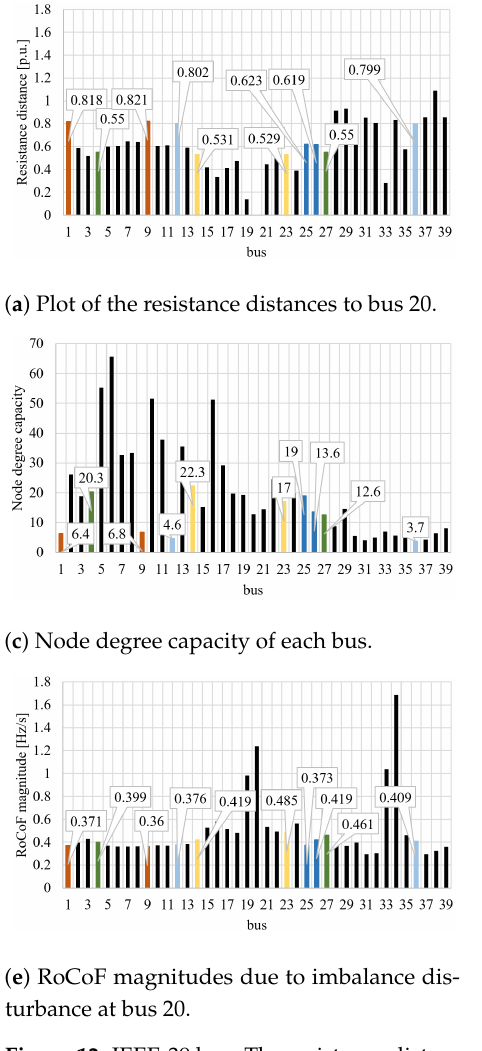
Figure 12. IEEE-39 bus: The resistance distances, node degree, and RoCoF plots for disturbances at bus 20 ( left ) and bus 29 ( right ),